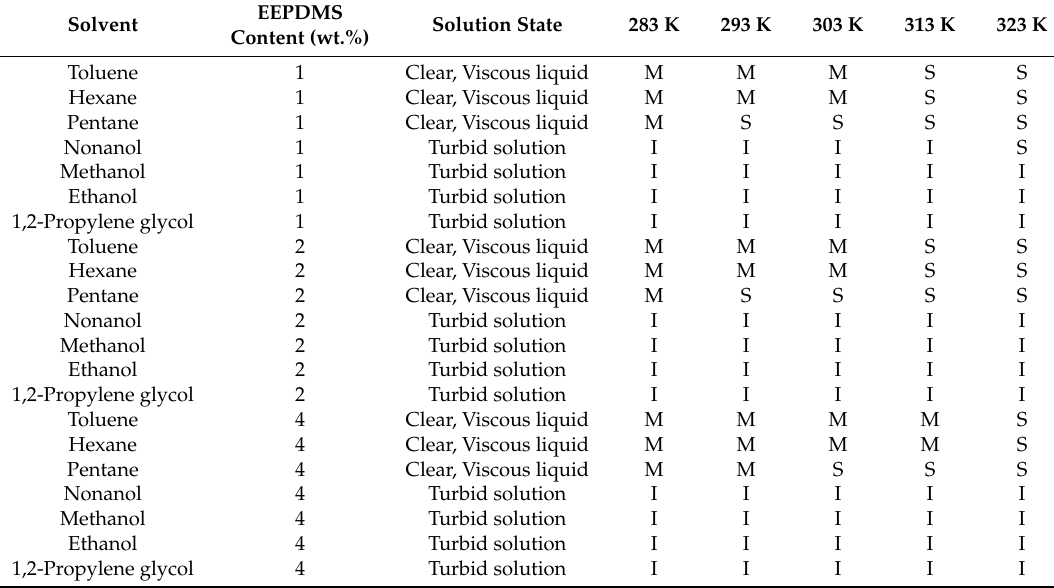
Table 2. Viscosity and Phase behavior of EEPDMS on Organic